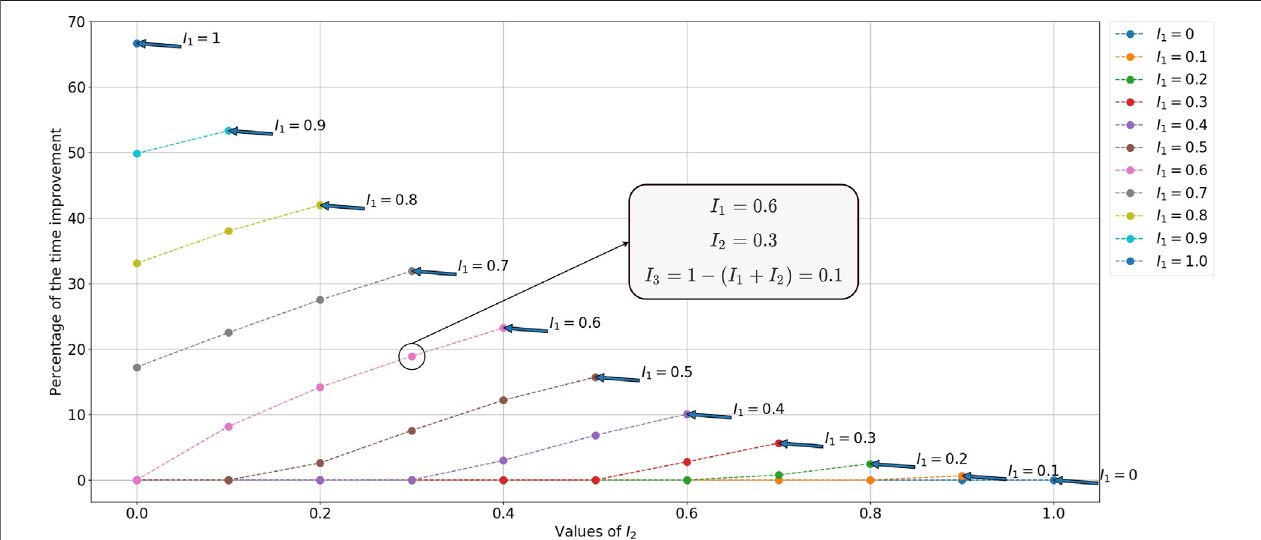
(cid:2) { 15 , 0 , 15 } and t (cid:2) { 75 , 0 , 75 } , so the ratio t (cid:2) 1/5. P ( A (cid:2) I A r A h / t A r h , g ) 1 , h